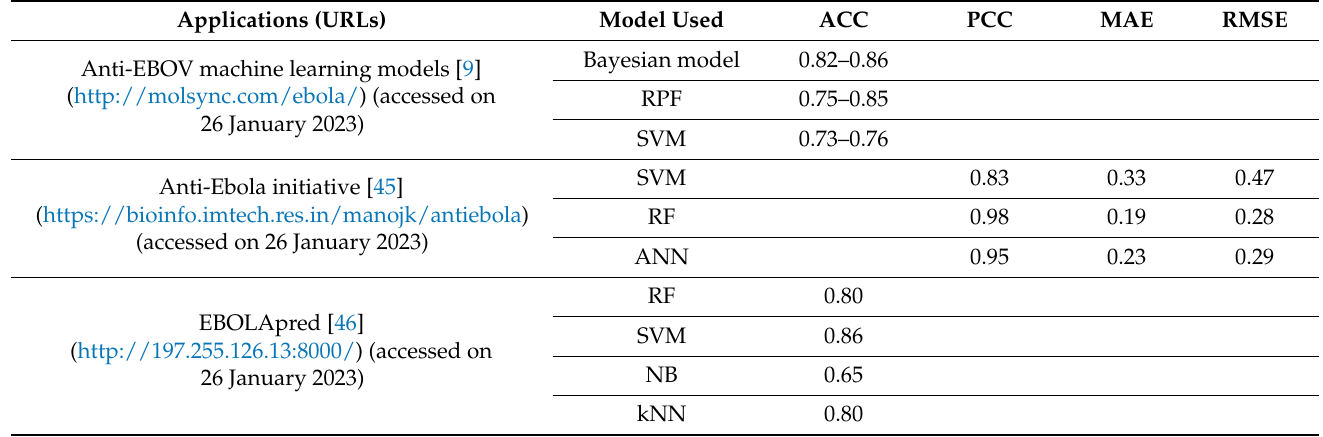
Table 1. Machine learning algorithms employed anti-EBOV research work with their varying perfor- mances. The models consisted of support vector machines (SVM), recursive partitioning forest (RPF), random forest models (RF), artificial neural network (ANN), naïve Bayes models (NB) and k-nearest neighbor models (kNN). Evaluation metrics included accuracy (ACC), Pearson correlation coefficient (PCC), mean absolute error (MAE), and root-mean-square error